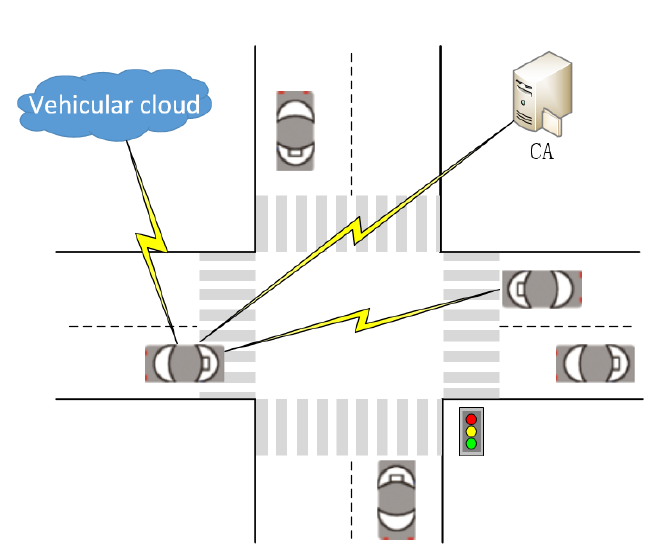
Figure 1. The system